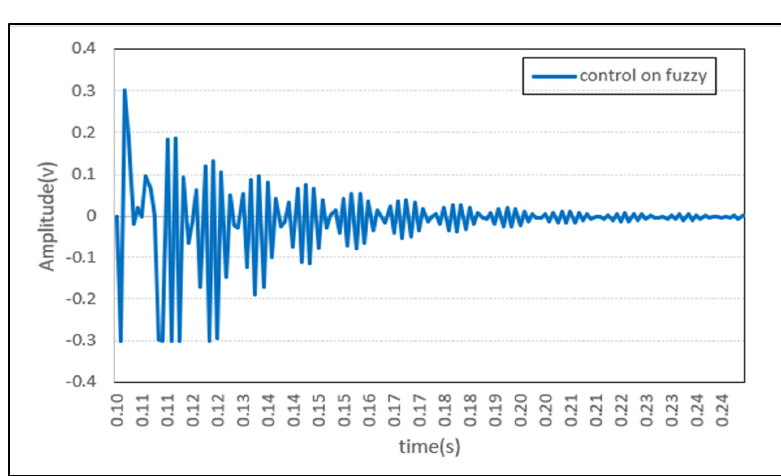
Fig. 10. Enlarged Shape of Vibration Suppression and Time Response of First Link under FLC.